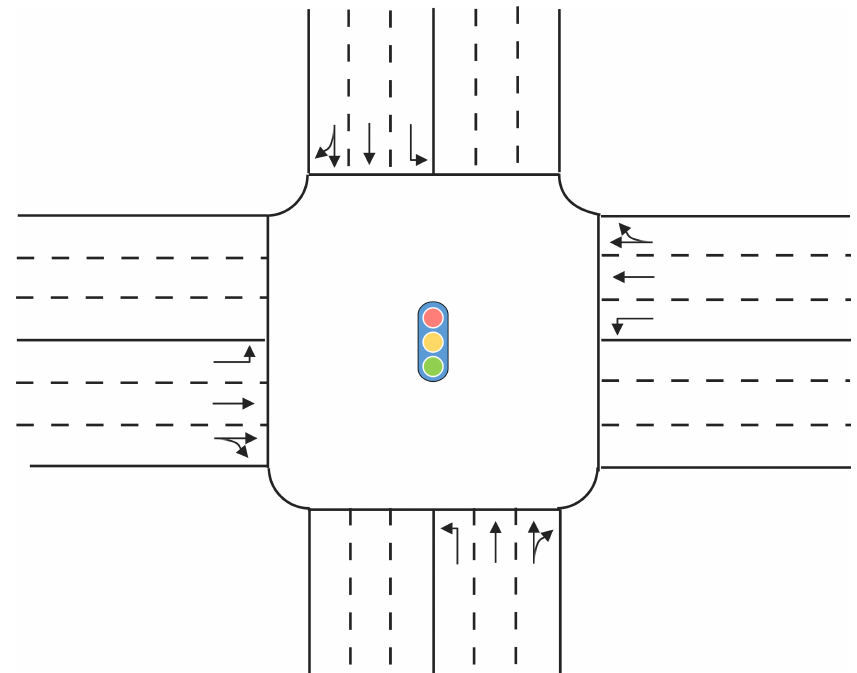
Figure 2. The simulated